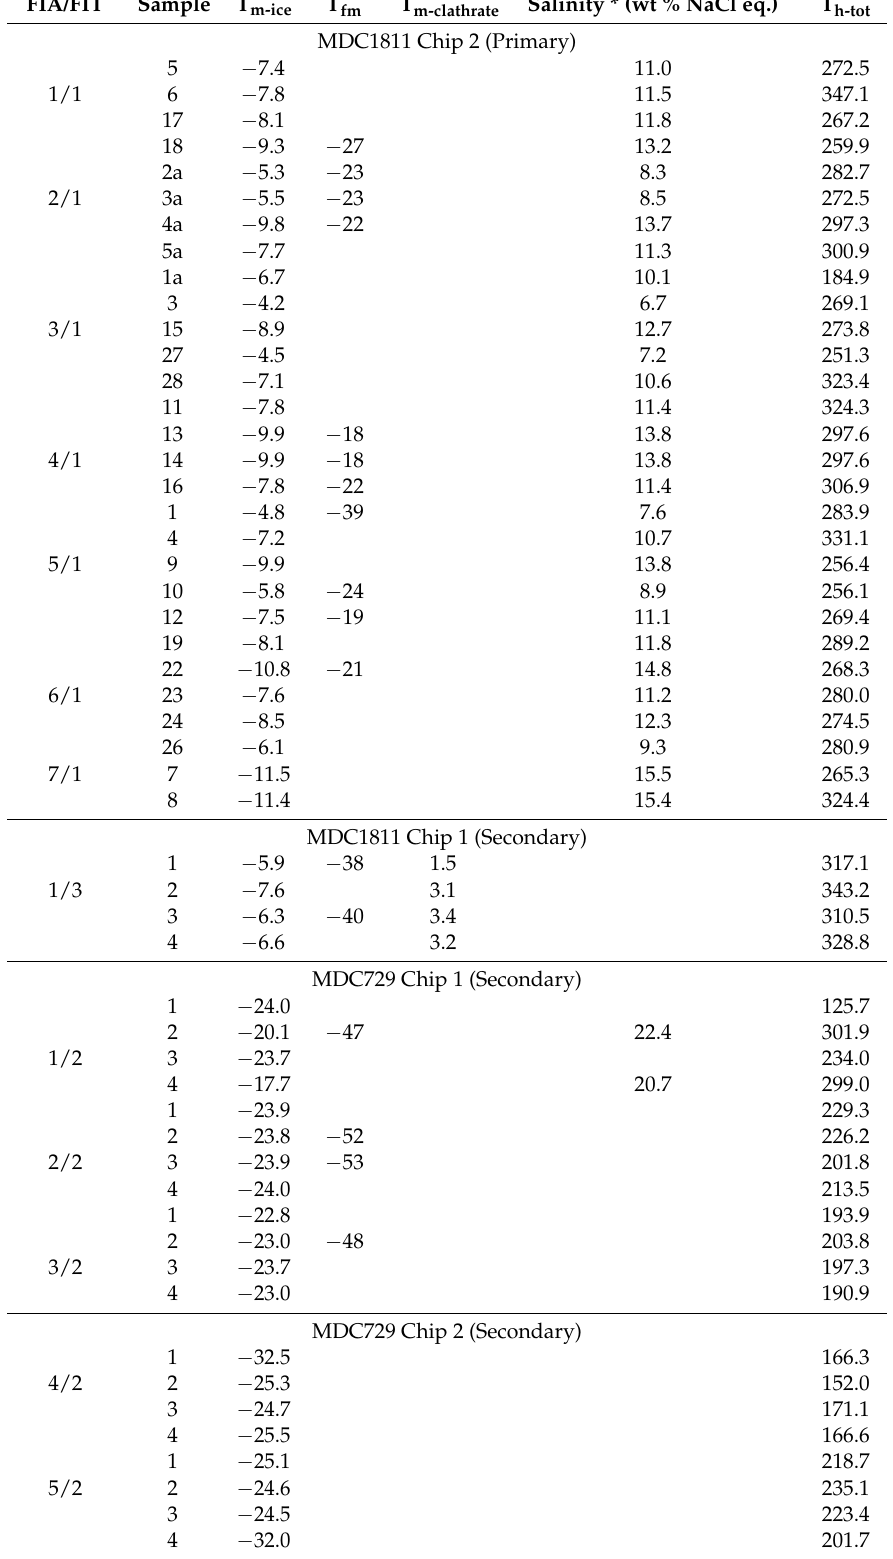
Table 3. Emerald-hosted fluid inclusion microthermometric